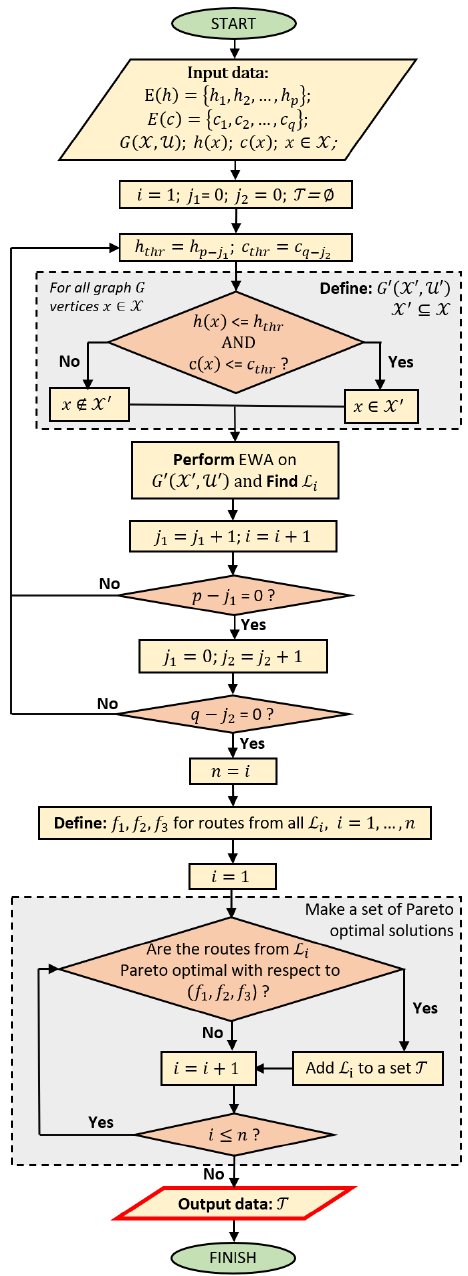
Figure 2. Block diagram of Algorithm 1.